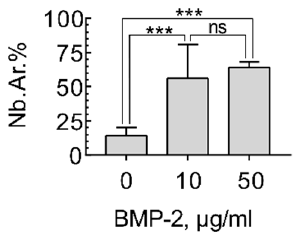
Figure 3. Volume of newly formed bone in the critical-size calvarial bone defect after implantation of the composition based on the reacetylated chitosan/ β -glycerophosphate hydrogel and 12 wt% PLA granules containing different BMP-2 doses in rats after 28 days. The significance of differences was indicated in accordance with the requirements of the American Psychological Association (APA): ns— p > 0.05; ***— p ≤ 0.001.